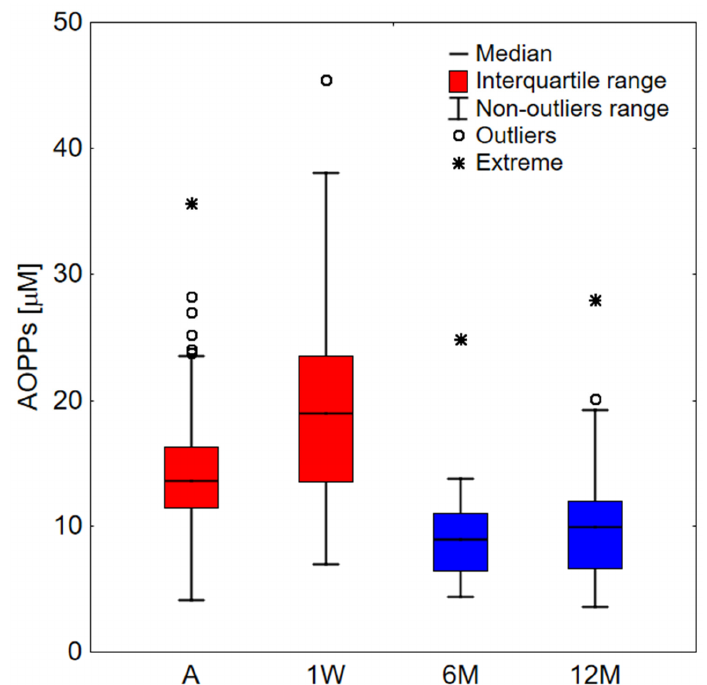
Figure 1. AOPPs values for a study group. A—COVID-19 patients on admission to hospital ( n = 66); 1W—COVID-19 patients one week upon admission ( n = 44); 6M—COVID-19 patients after 6 months from infection ( n = 30); 12M—COVID-19 patients after 12 months from infection ( n = 27). Data far away by more than 1.5 and 3 interquartile range from this range were considered outliers and extreme, respectively. Table 2. The level of significance ( p -values) between the study group. A—COVID-19 patients on admission to hospital; 1W—COVID-19 patients one week upon admission; 6M—COVID-19 patients after 6 months from infection; 12M—COVID-19 patients after 12 months from infection. Red-colored values indicate statistical significance ( p < 0.05). For data comparison, we used AOPPs measure- ments from the same patients but recorded at different times.